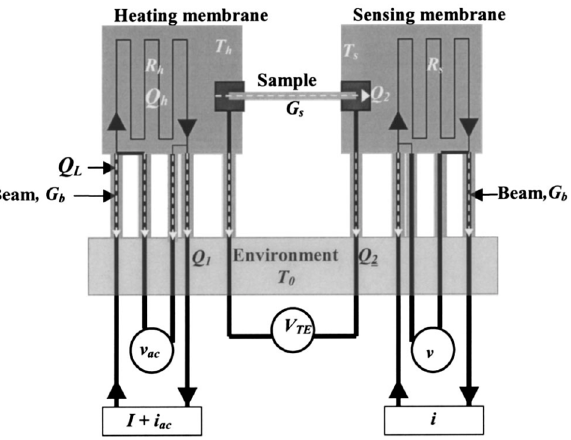
Figure 5. Thermal bridge method [84]. Reprinted with permission from ref. [84]. American Society of Mechanical Engineers ASME.